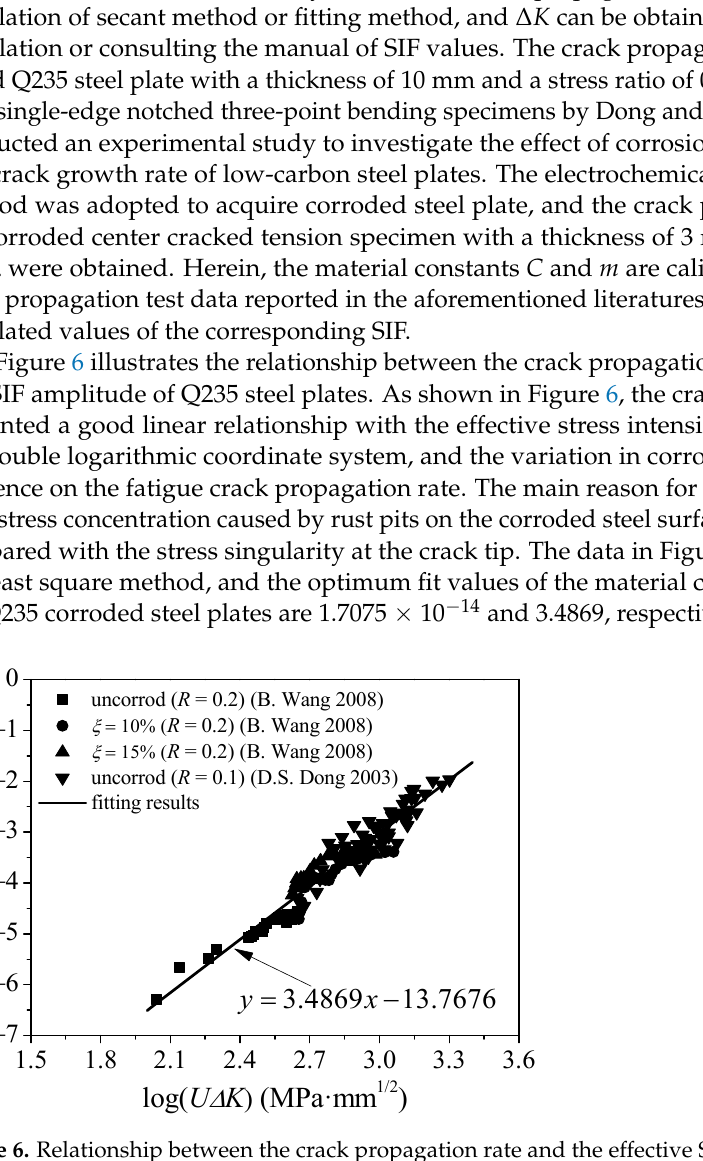
Figure 6. Relationship between the crack propagation rate and the effective SIF amplitude of Q235 steel plates.